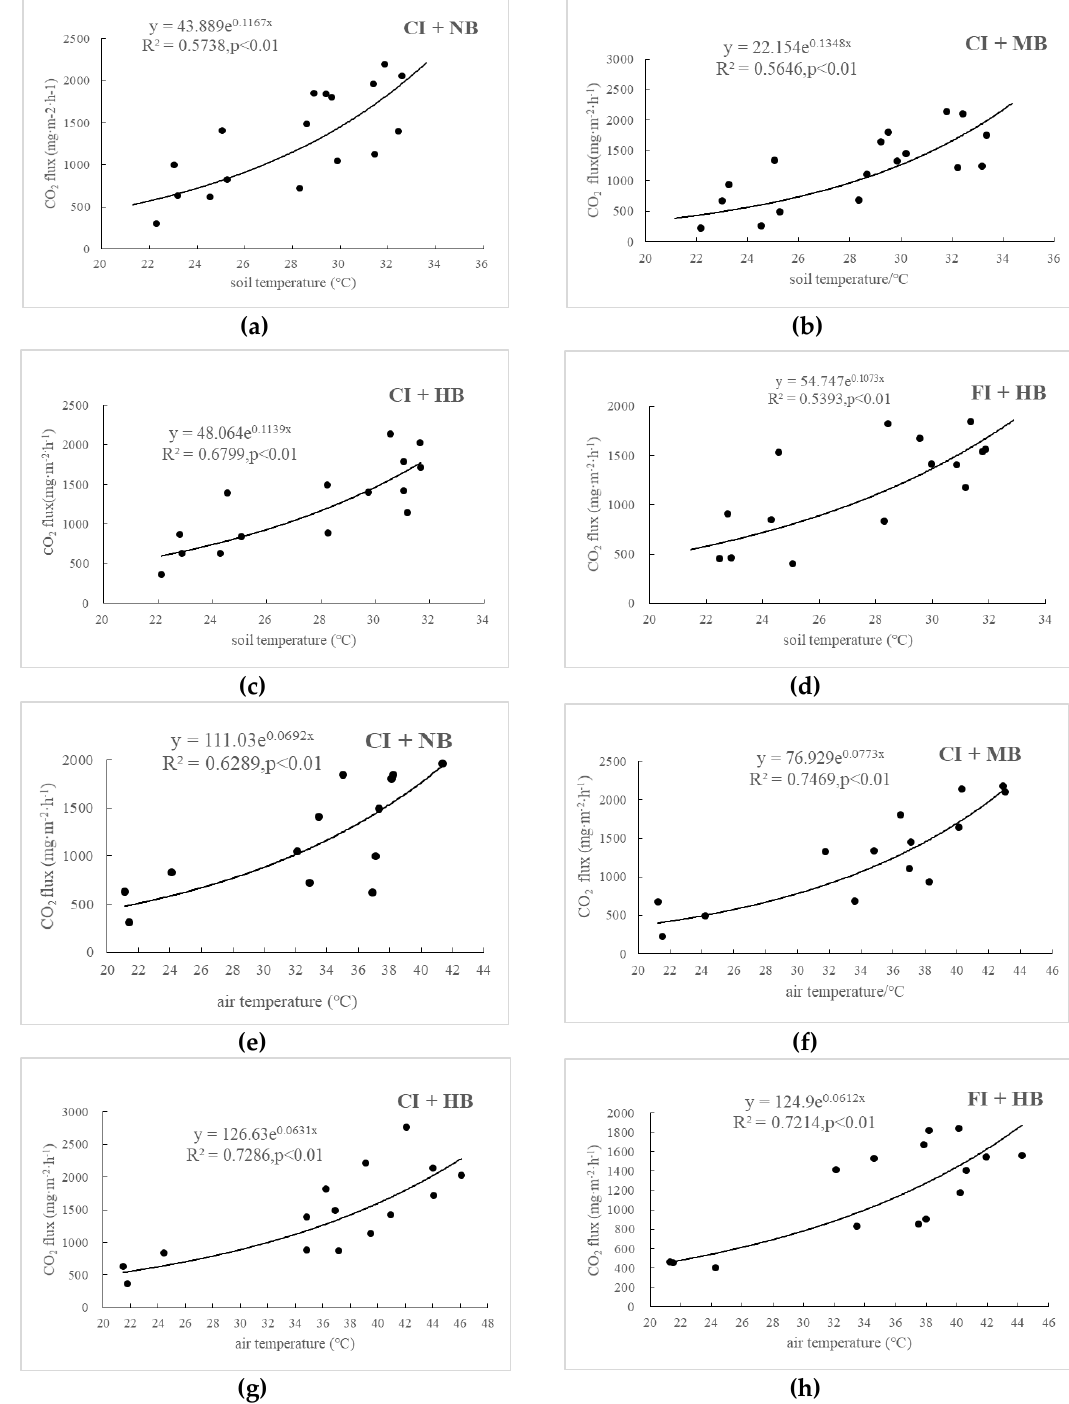
Figure 4. Effects of soil temperature on CO 2 emissions in CI + NB ( a ), CI + MB ( b ), CI + HB ( c ), FI + HB ( d ) and relationship between CO 2 emissions and air temperature in CI + NB ( e ), CI + MB ( f ), CI + HB ( g ), and FI + HB ( h ).